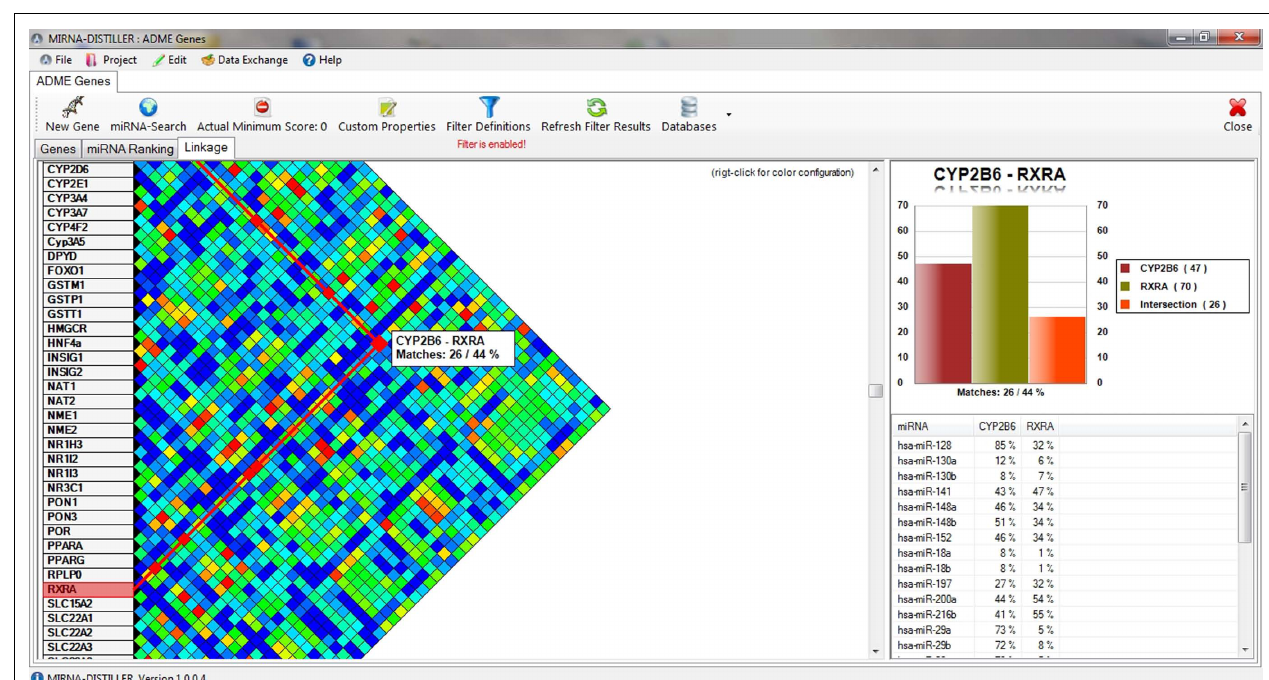
FIGURE 5 | Example of validated gene-miRNA interactions. has-miR-122 is on the top of the miRNA ranking for these